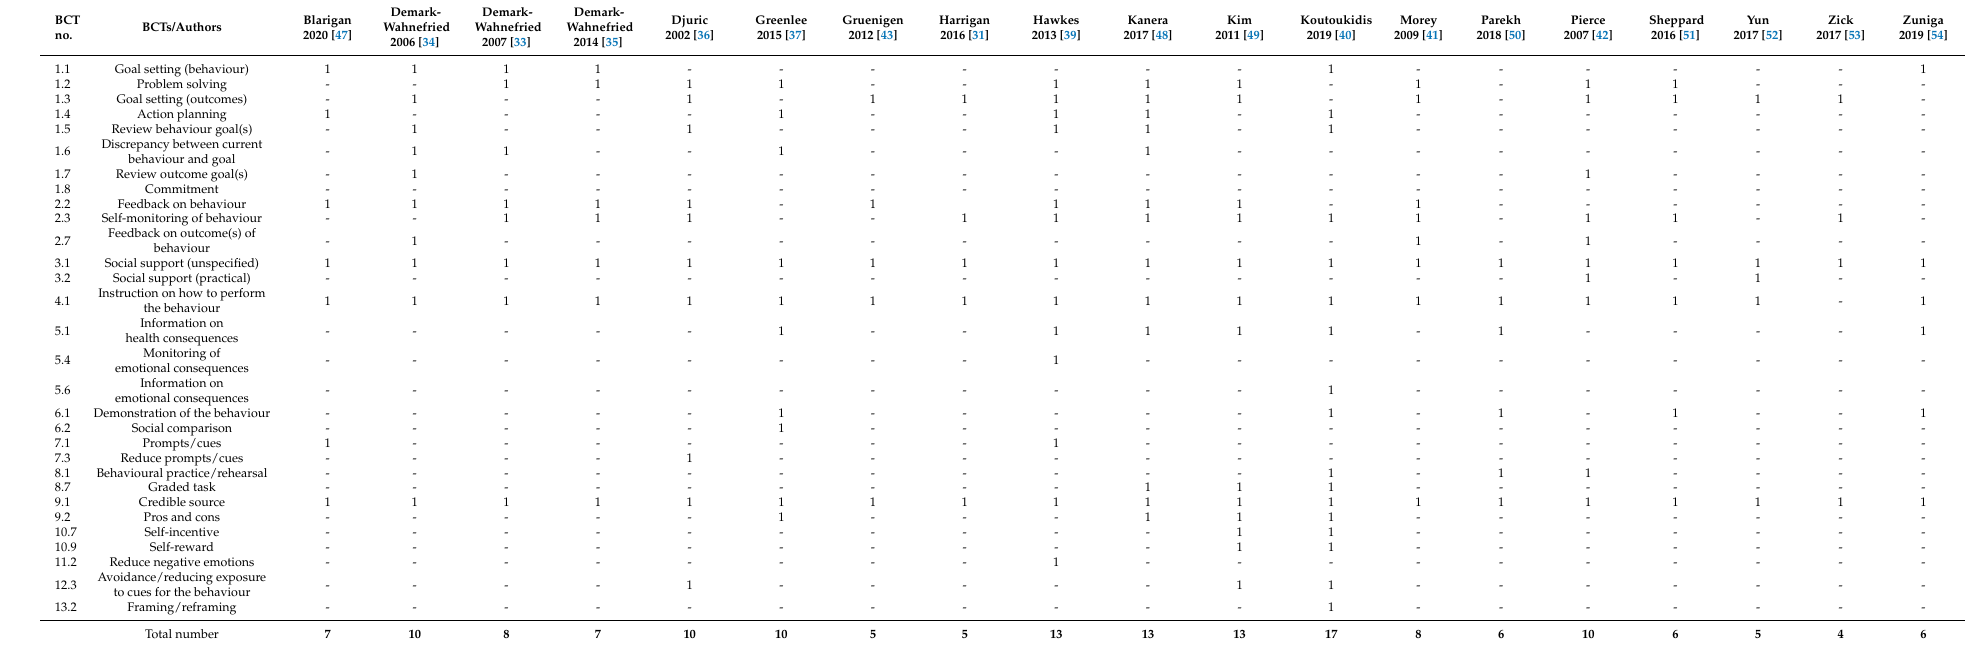
Table 3. Behaviour change techniques taxonomy mapping of the